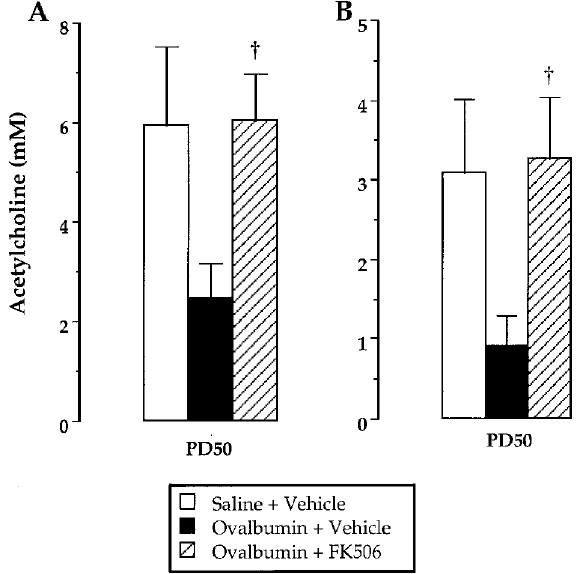
FIG. 1. Effect of FK506 on antigen-induced bronchial hyper- reactivity to inhaled acetylcholine in sensitized guinea-pigs. Bronchial reactivity to inhaled acetylcholine (1–50mM) was evaluated in saline- and ovalbumin-challenged guinea-pigs, treateds.c. with 0.5mg/kg FK506 or with its vehicle, 1h before and 5h after the challenge, and used 72h thereafter. Results are expressed as provocative dose (PD) of acetylcho- line, calculated from the dose-response curve, required to increase the R L (panel A) or to decrease the C dyn (panel B) by 50cm H 2 O/(litre/s) (PD50). The baseline R L were of 155.7 ± 9.6, 188.3 ± 20.6 and 171.2 ± 10.5cm H 2 O/(litre/s), and that C